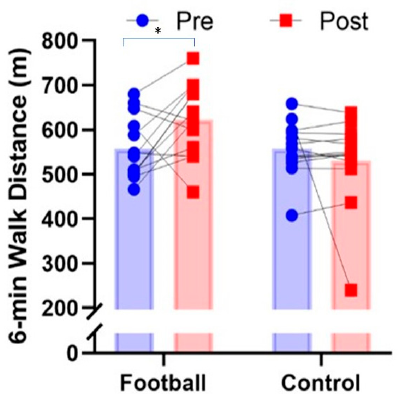
Figure 5. Group mean and individual performance for percentage body fat (%) before and after in recreational football for health intervention group and matched controls.